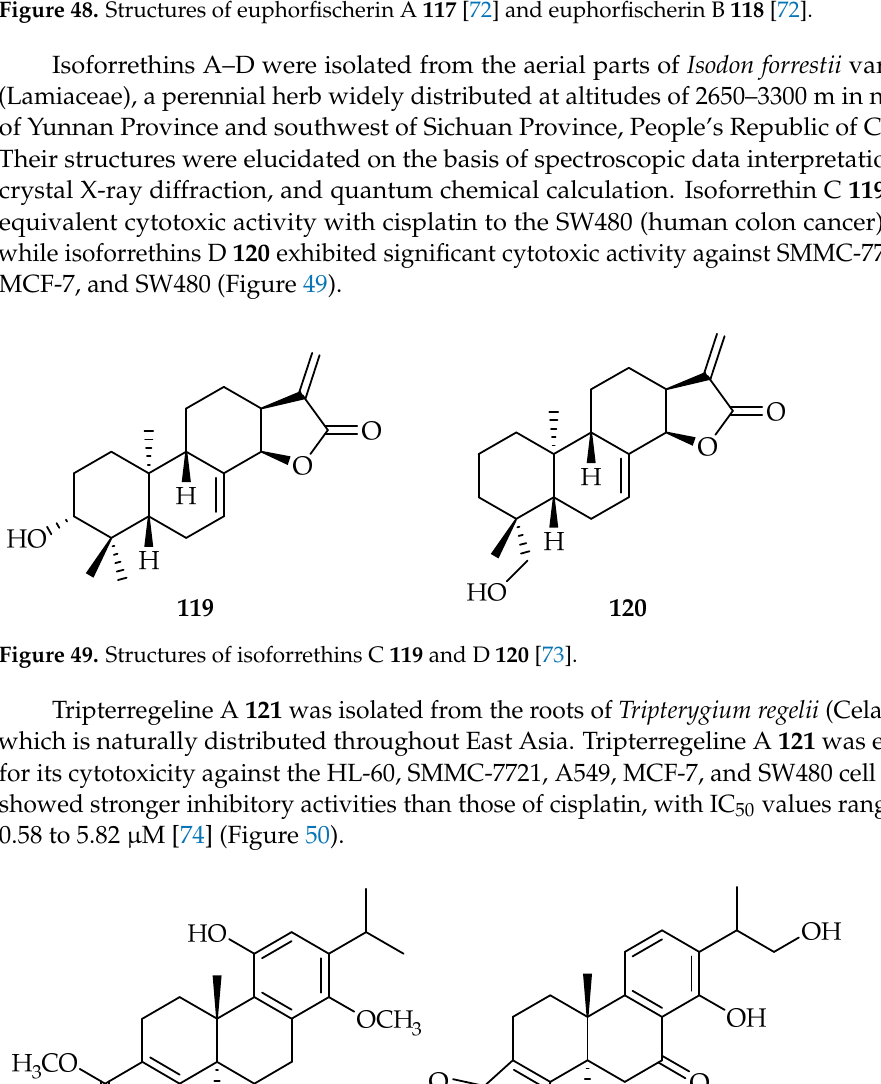
Figure 48. Structures of euphorfischerin A 117 [72] and euphorfischerin B 118 [72].